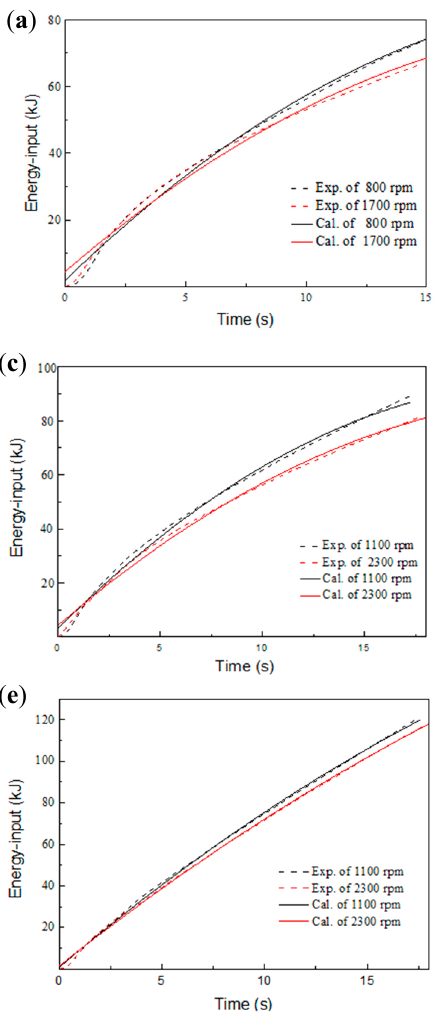
Figure 12. Comparison between calculated and experimental values of energy-input under different rotational speeds when welding pressure was constant at ( a ) 25 MPa, ( b ) 40 MPa, ( c ) 80 MPa, ( d ) 120 MPa, and ( e ) 160 MPa.